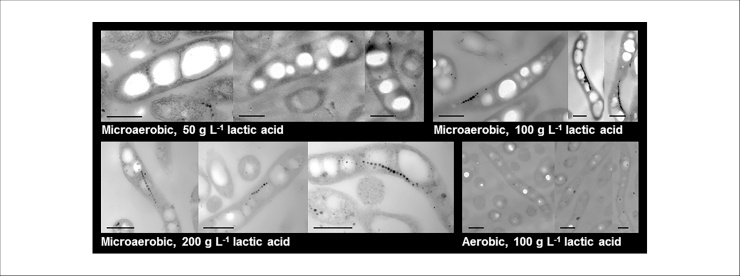
Transmission electron micrographs of bacteria from oxygen-limited and aerobic fermentations conducted with different feed lactic acid concentrations. The length of each scale bar is 0.5 μm.